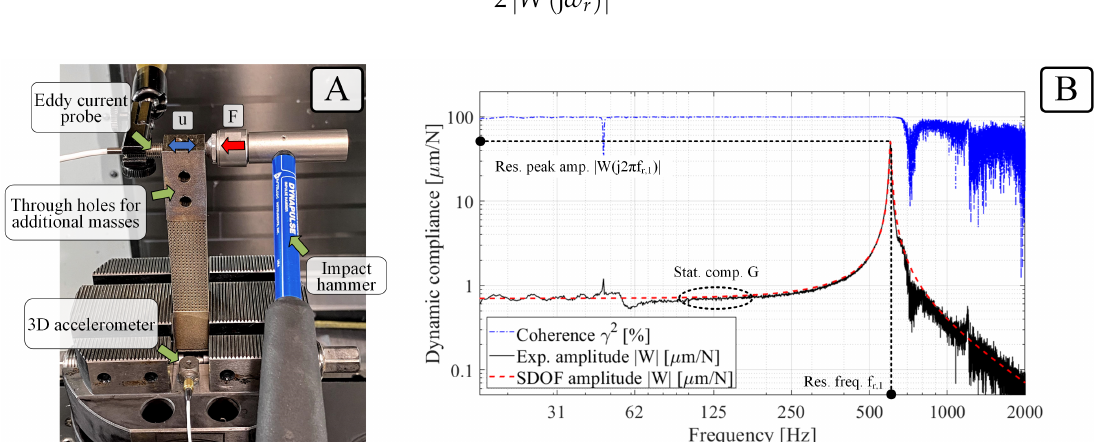
Figure 4. Identification of the global dynamic behavior of the lattice structures: experimental setup for pulse testing.